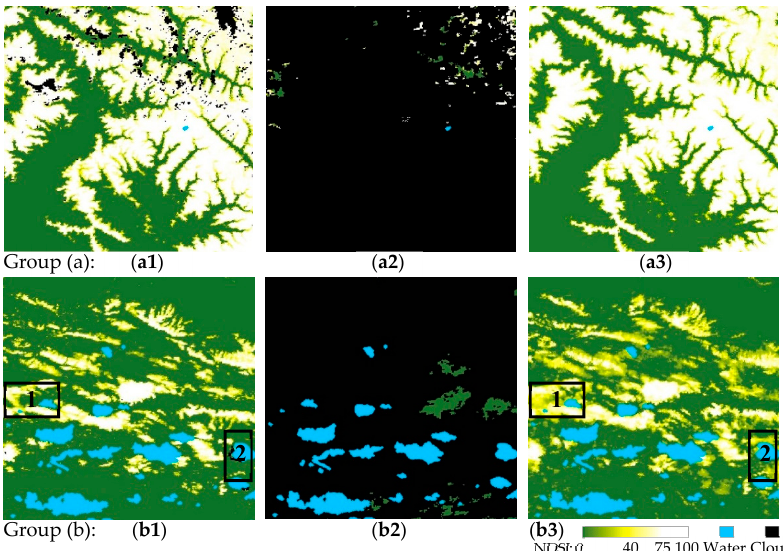
Figure 8. Details of A3 on 24 March 2016 (group (a)) and A4 on 10 September 2017 (group (b)). ( a1 , b1 ) “Ground truth”. ( a2 , b2 ) “Observed data”. ( a3 , b3 ) The cloud-removed results.